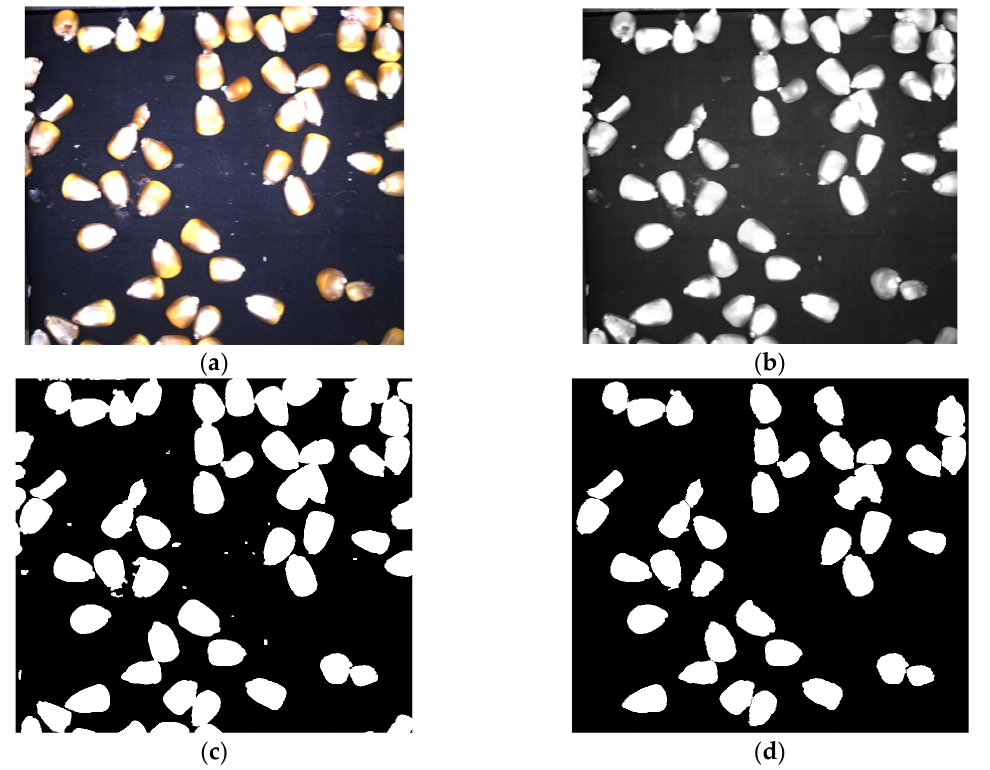
Figure 5. Corn kernel harvest image preprocessing. ( a ) Original material collection image. ( b ) Image after filtering and open arithmetical processing. ( c ) Binary image. ( d ) Preprocessed images. Table 5. Statistics of variation range of corn kernel and impurity characteristics and threshold